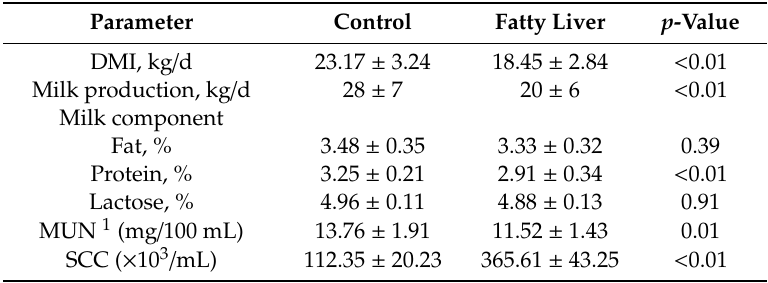
Table 4. Milk production and milk component of control and fatty liver dairy